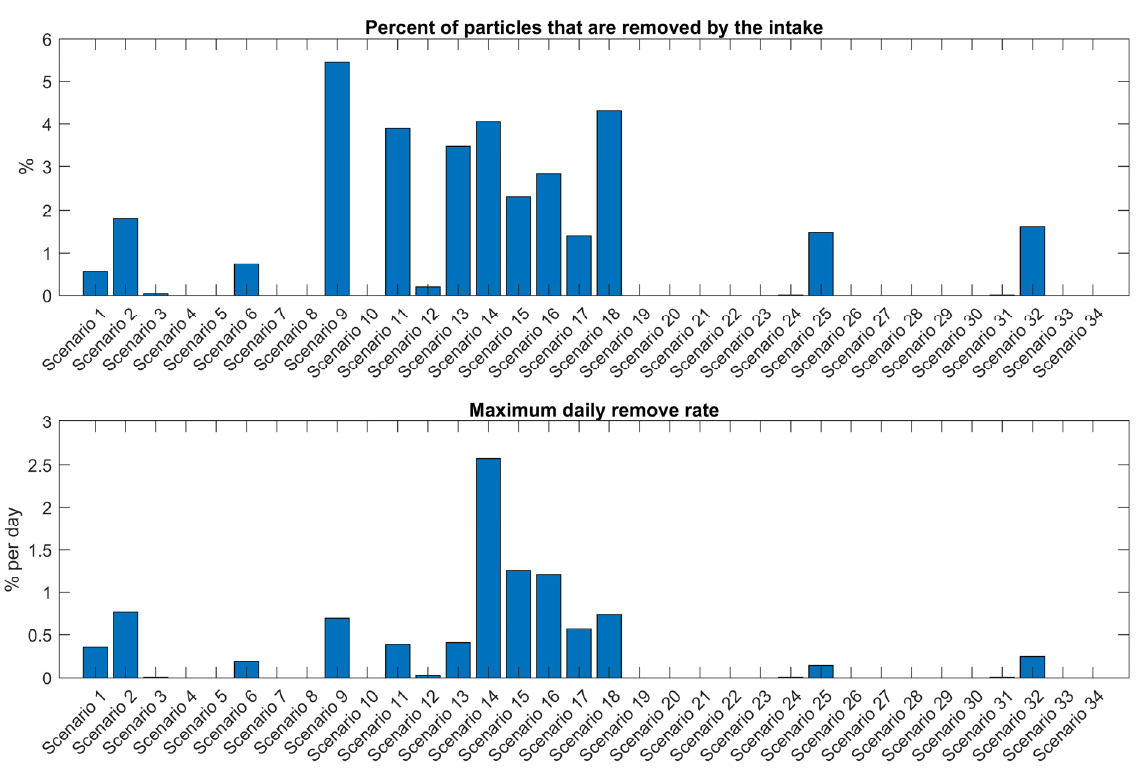
Figure 9. A summary of all the forward-tracking scenarios showing the total number of particles removed by the intake (i.e., percent of particles that are removed by the intake) and the maximum daily removal rate.